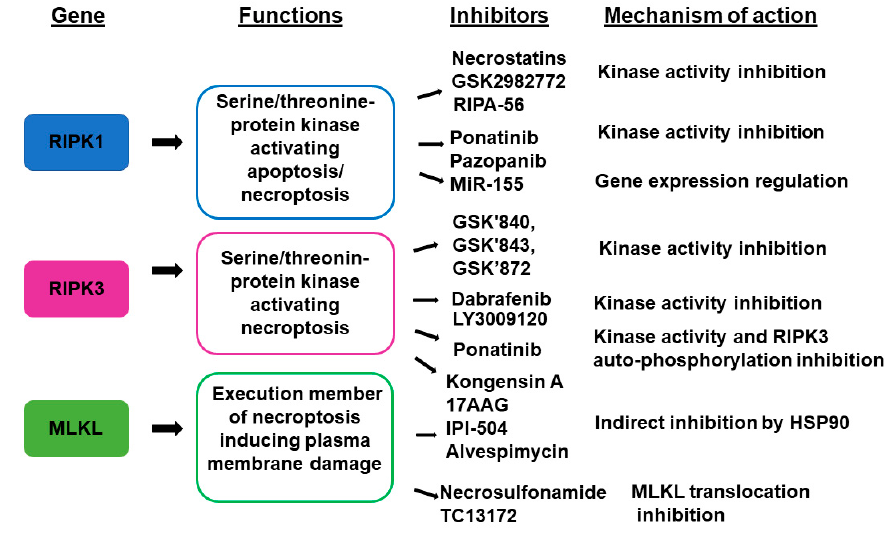
Figure 3. Key necroptotic genes and their inhibitors.